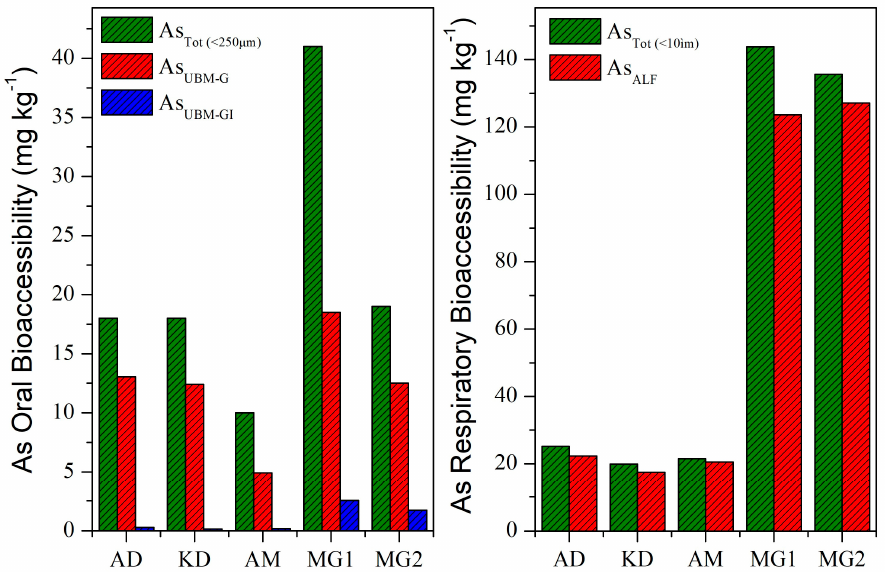
Figure 4. Arsenic bioaccessibility (in mg kg −1 ) of lignite fly-ash samples in ( left ) gastric (G)/gastrointestinal (GI) and ( right ) lung fluids.